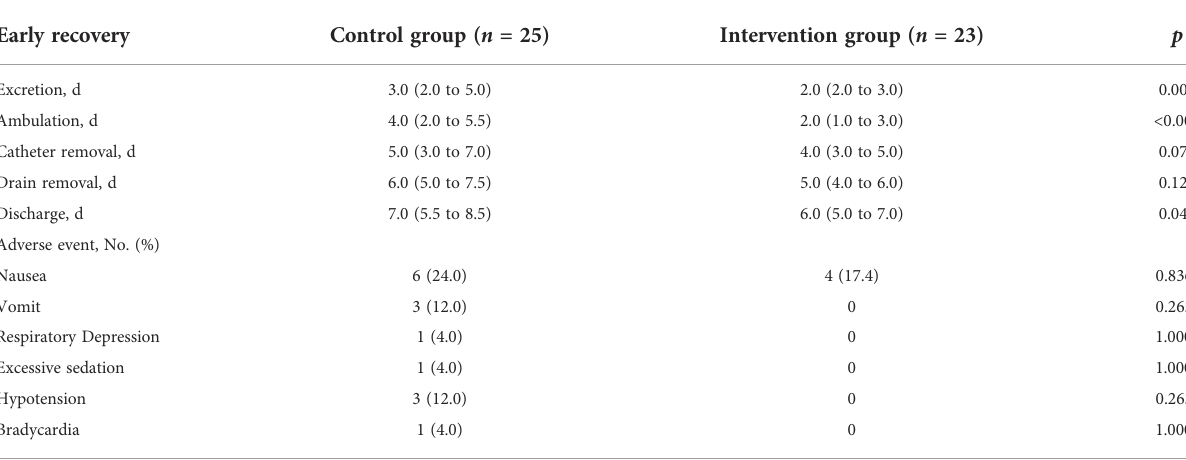
TABLE 4 Early postoperative recovery and adverse